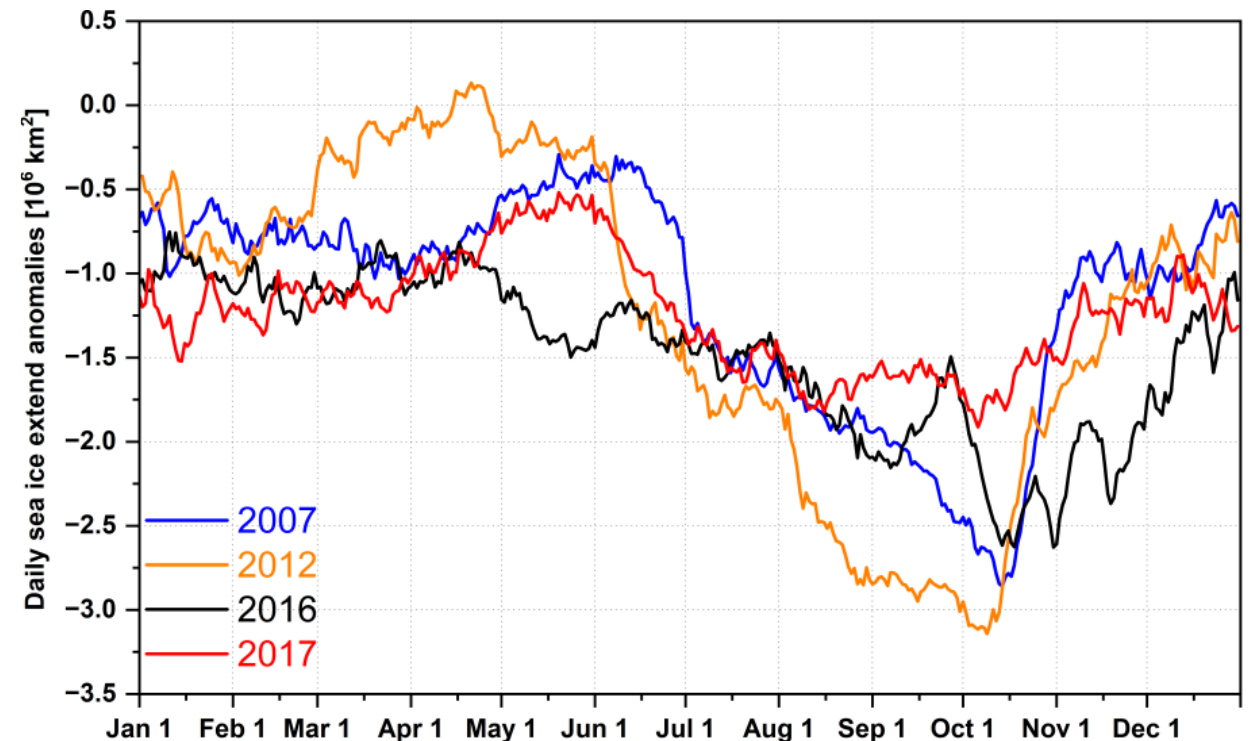
Figure 3. Daily sea ice extent anomalies for the years 2007 (blue), 2012 (orange), 2016 (black), and 2017 (red).